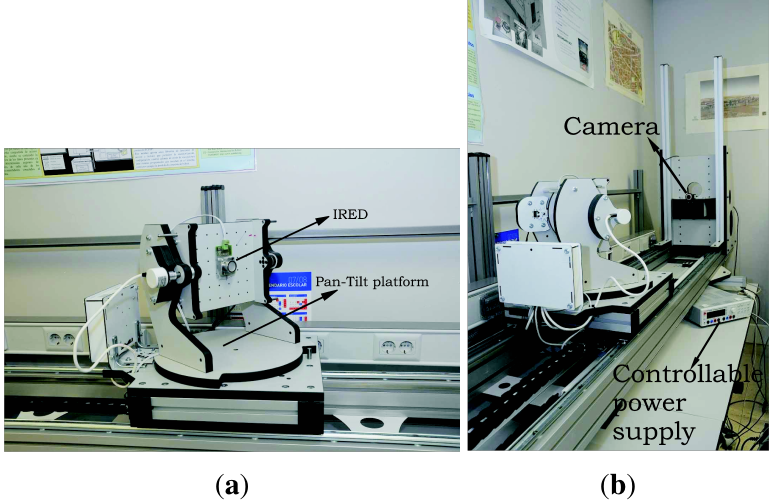
Figure 9. Measurement station used in practical validation of the alternative to measure the distance between the camera and the IRED. ( a ) Pan-tilt platform with the circular IRED attached; ( b ) Platform shown from another angle to depict the